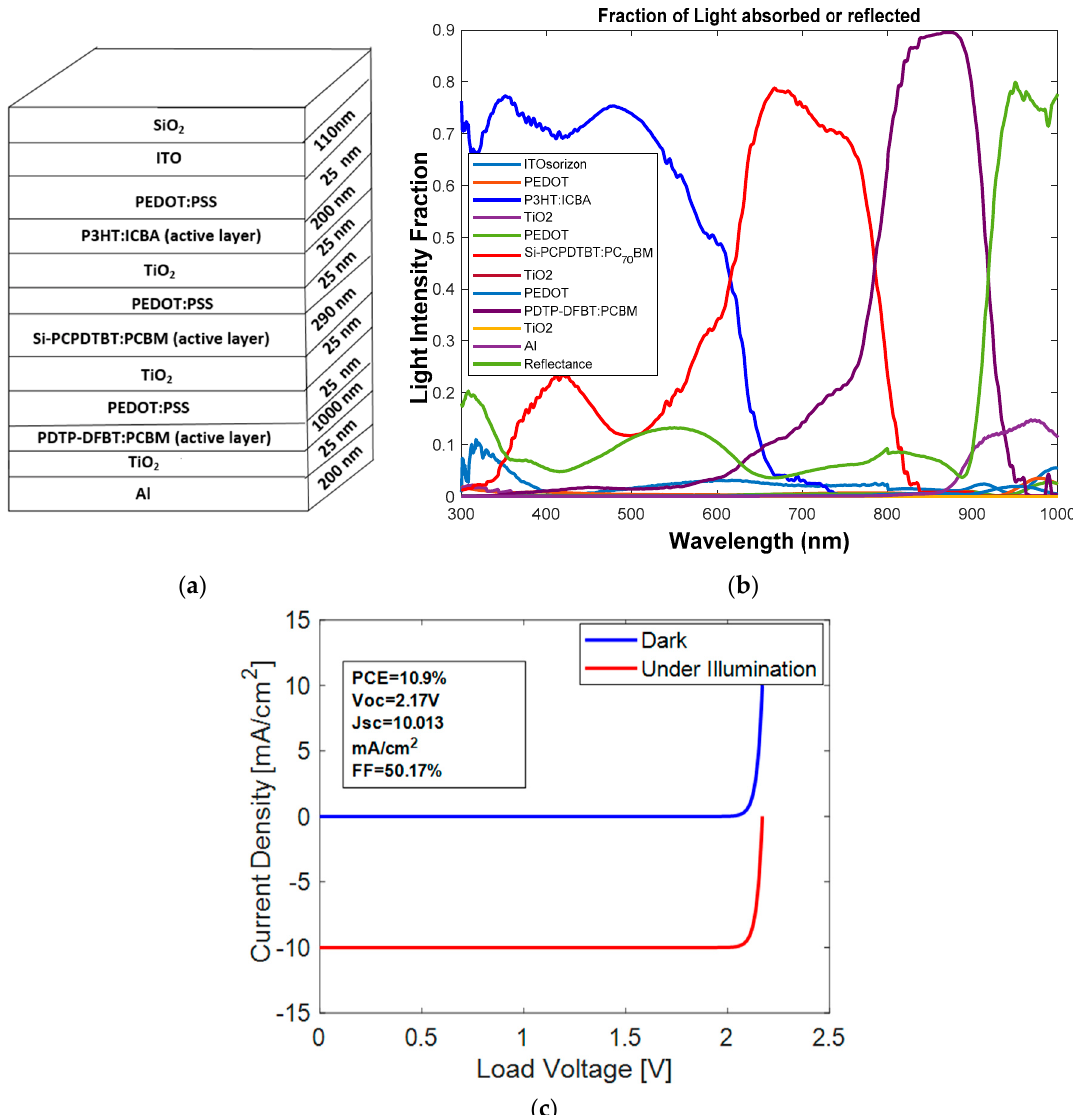
Figure 7. ( a ) Stack diagram; ( b ) variation of light intensity versus wavelength; and ( c )